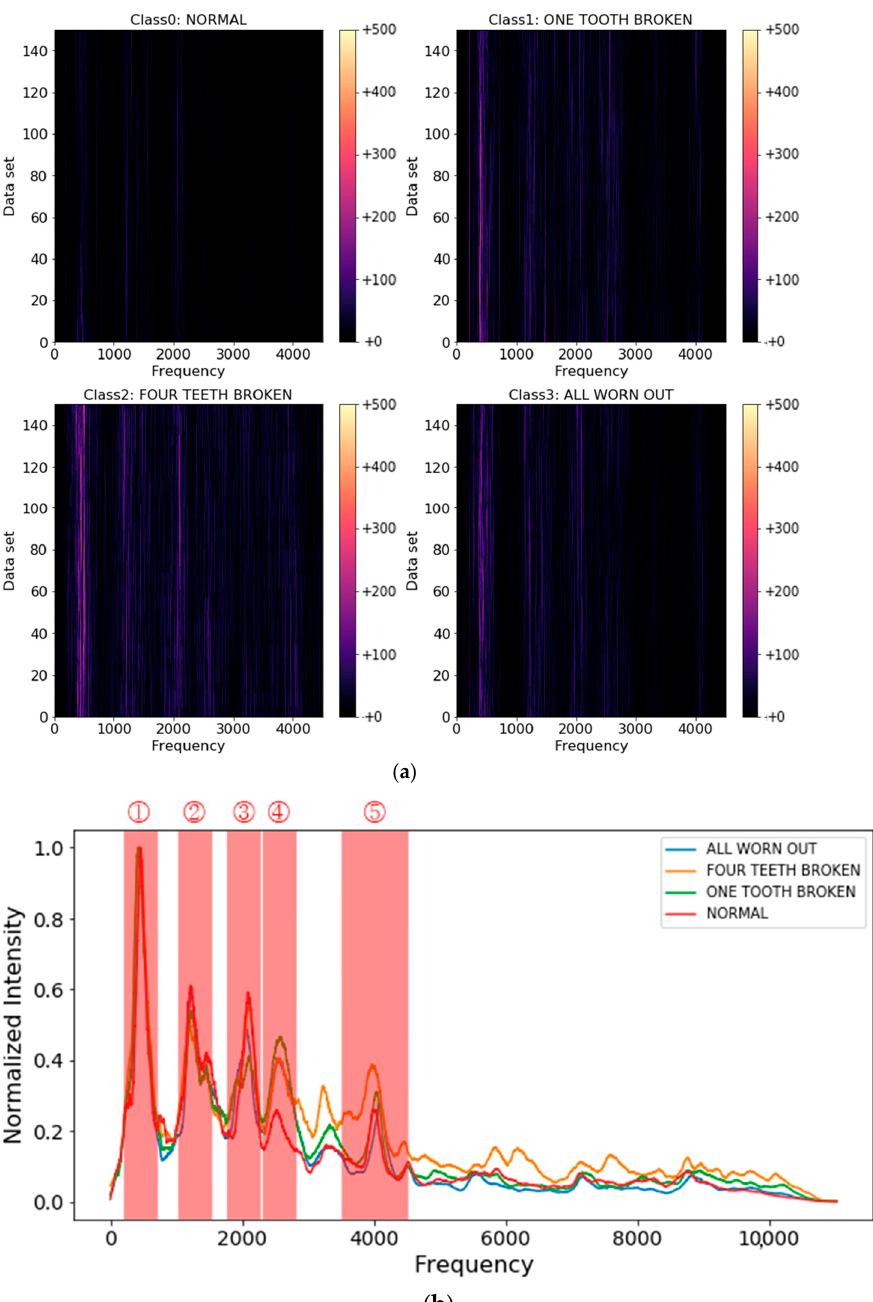
Figure 4. ( a ) Total of 150 samples of acoustic data in terms of frequency for each case. ( b ) Averaged frequency data for each gear case and frequency band selection example.